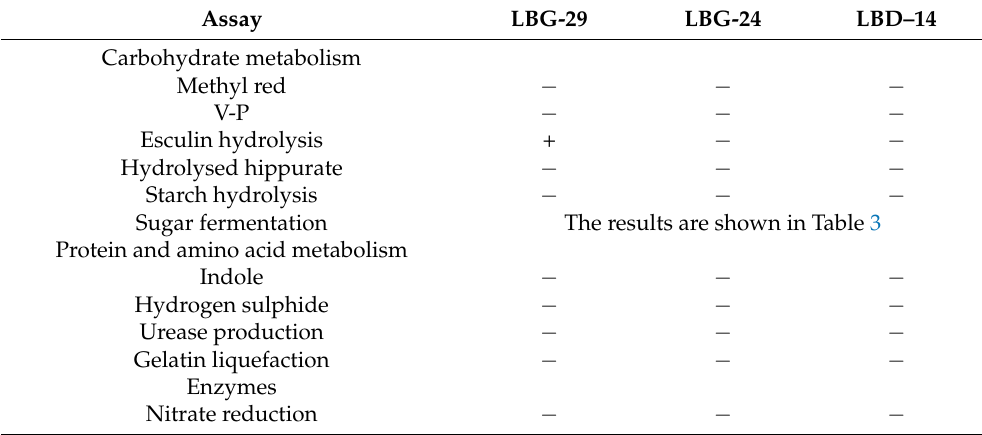
Table 2. Physiological and biochemical characteristics of the screened Levilactobacillus brevis strains. Assay LBG-29 Carbohydrate metabolism Methyl red